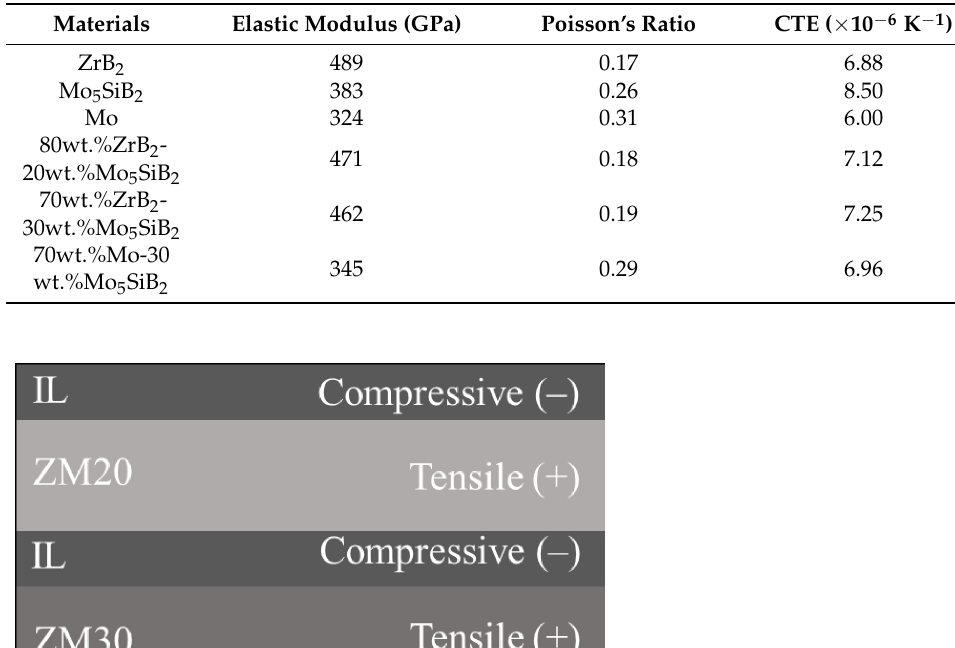
Table 2. Elastic modulus, Poisson’s ratio, and CTEs of raw materials and the laminated ceramics.